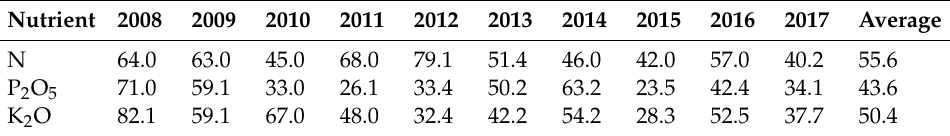
Table 2. Amount of nutrient inputs of the Level 1 treatment (kg ha − 1